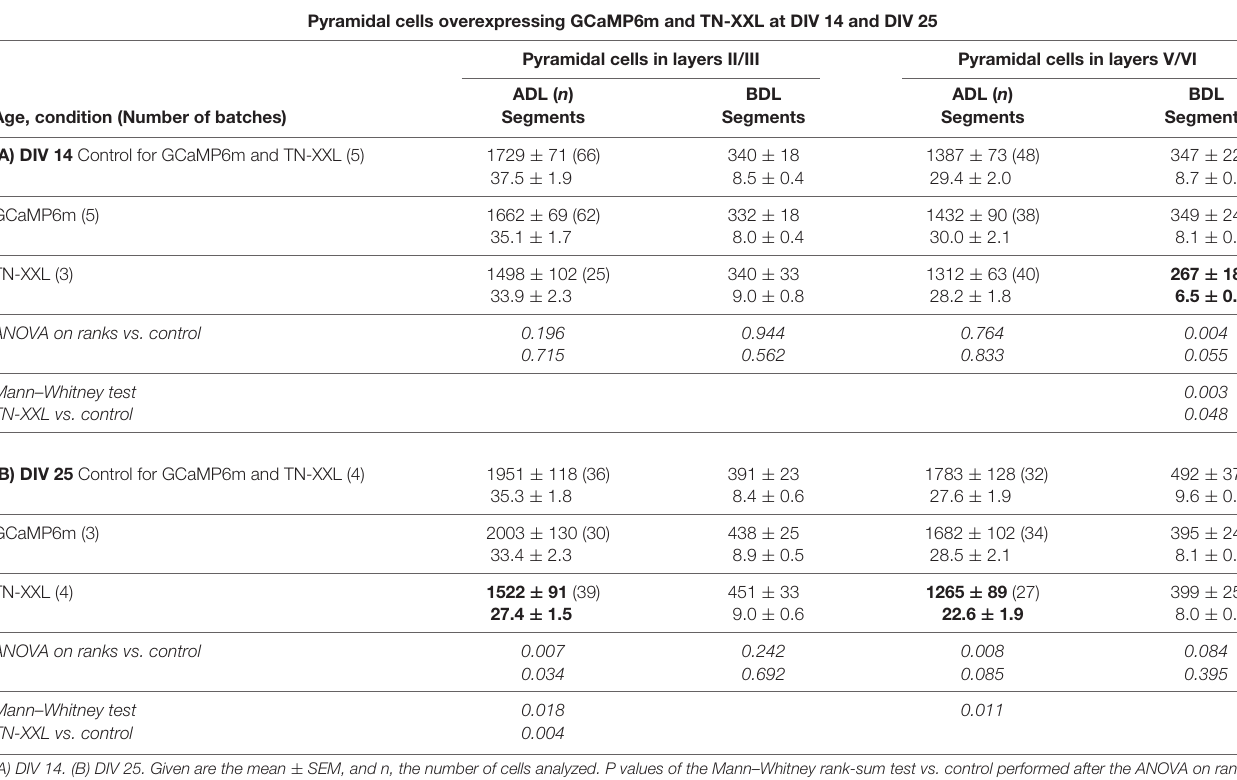
TABLE 3 | Measures of apical and basal dendrites of pyramidal neurons of layers II/III and V/VI expressing GCaMP6m and TN-XXL, respectively, vs. batch-internal EGFP expressing neurons as control. Pyramidal cells overexpressing GCaMP6m and TN-XXL at DIV 14 and DIV 25